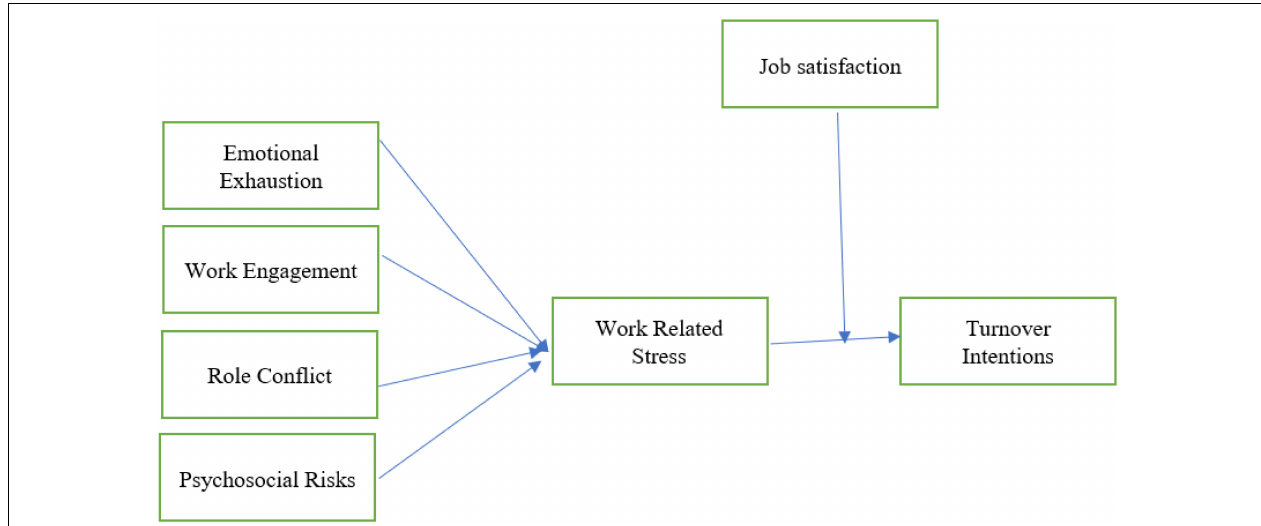
FIGURE 1 | Conceptual